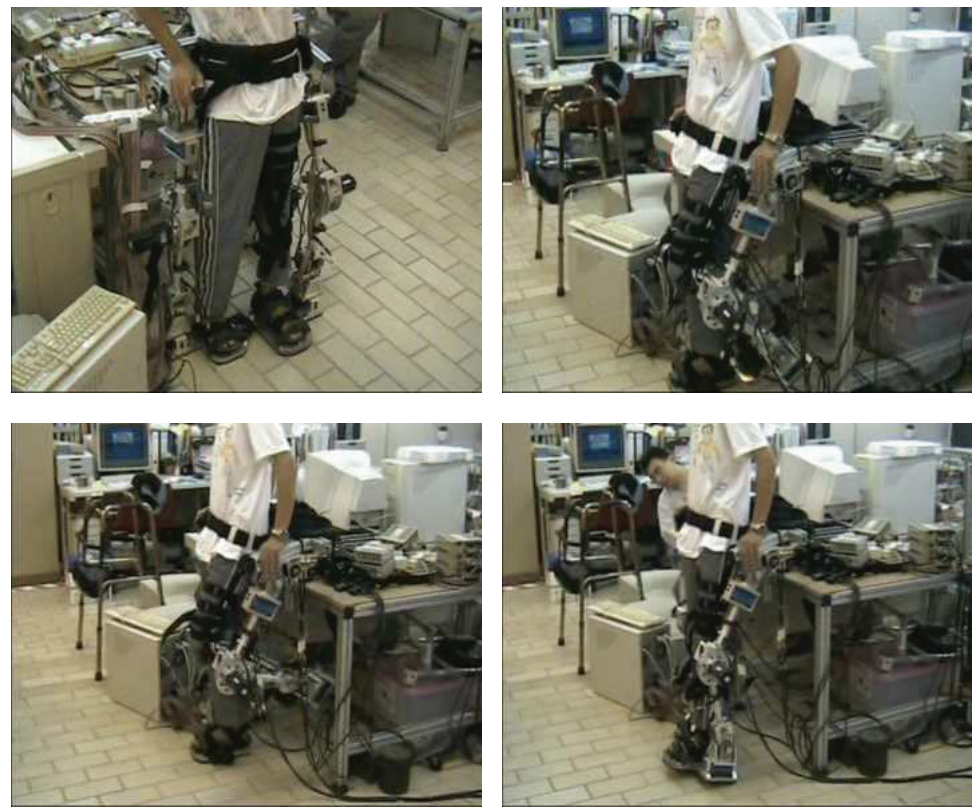
Figure 29 Snapshots of an exoskeleton rehabilitation trial with a post-stroke client.